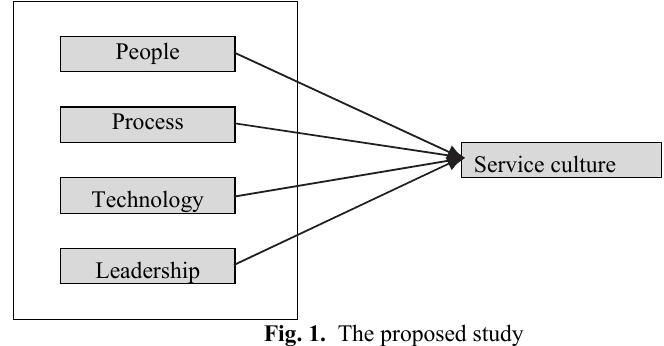
Fig. 1. The proposed